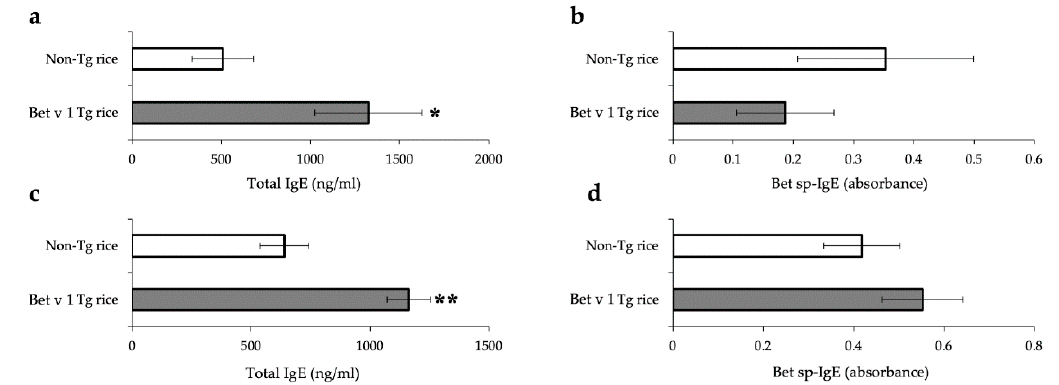
Figure 9. Serum concentration of total IgE ( a , c ) and Bet v 1-specific IgE ( b , d ) in mice fed with Bet v 1 Tg or non-Tg rice in